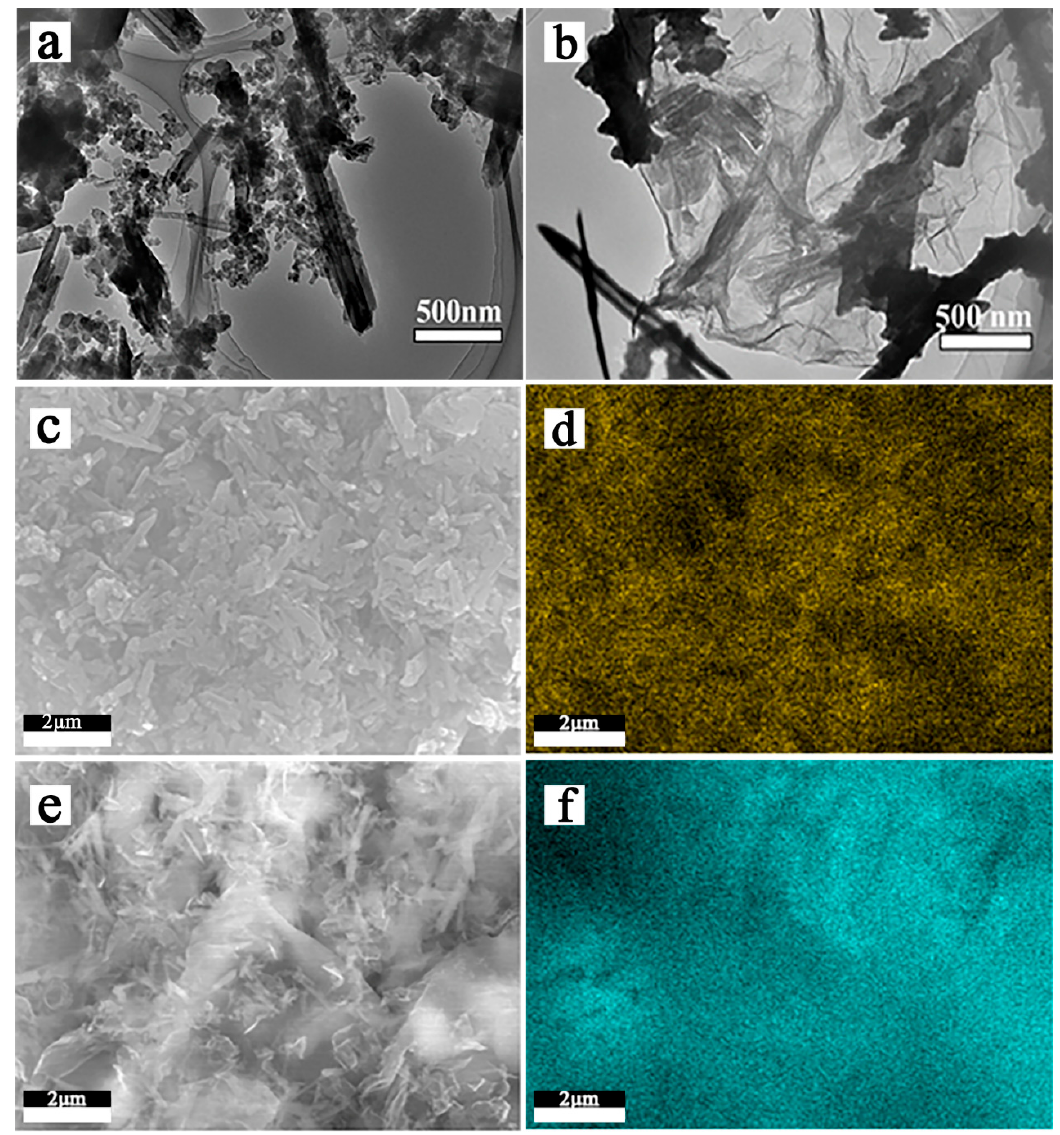
Figure 3. TEM images of HNTs-80/S ( a ) and RGO@HNTs/S composites ( b ); SEM images of HNT-80/S composites ( c ) and sulfur elemental mapping ( d ); SEM images of RGO@HNT-80 / S composites ( e ) and composites ( c ) and sulfur elemental mapping ( d ); SEM images of RGO@HNT-80/S composites ( e ) and sulfur elemental mapping ( f sulfur elemental mapping ( f ).